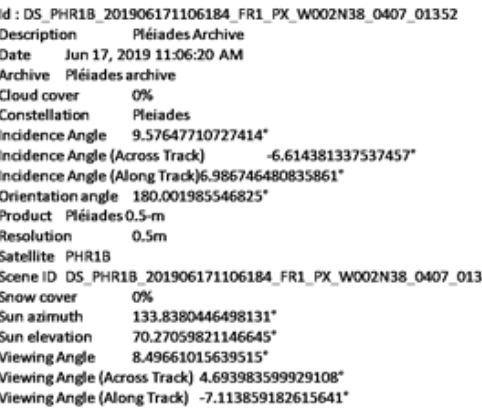
Figure 10. GIS information used for field control.